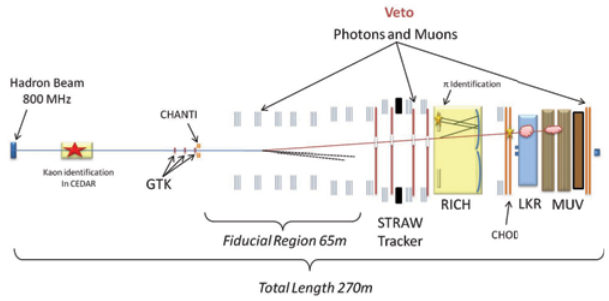
Figure 2. Schematic view of the NA62 experiment showing the main sub-detectors (not to scale). The main elements for the detection of the K + decay products are located along a 170 m long region starting about ∼ 100 m downstream of the beryllium target. Useful K + decays will be detected within a 65 m long fiducial decay